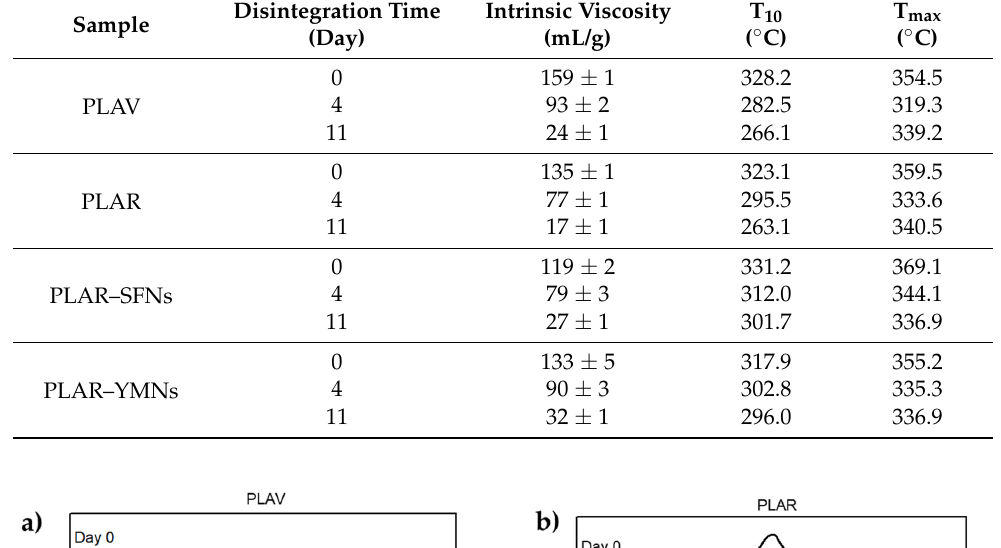
Table 4. Intrinsic viscosity and TGA parameters of the samples during disintegration under compost- ing conditions.